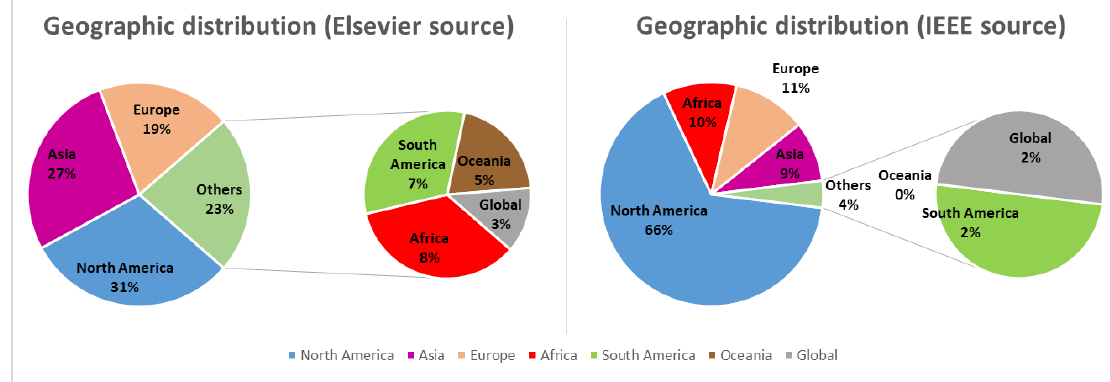
Figure 5. Paper geographic distribution, by